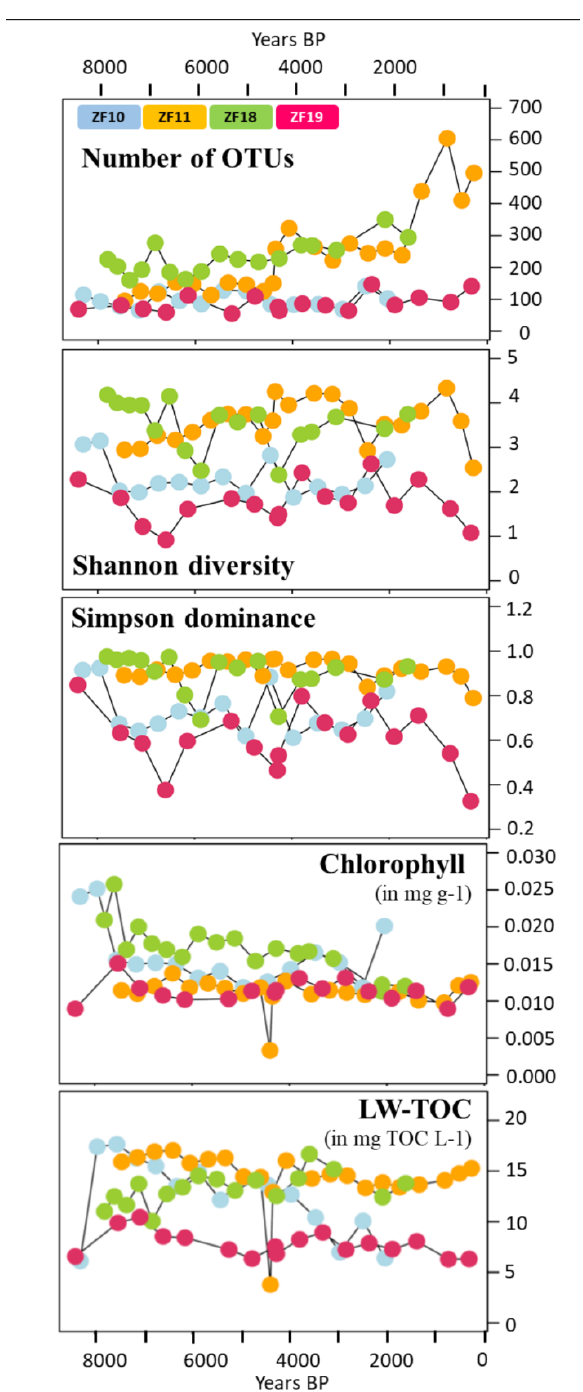
Figure 4. Time series of the diversity metrics of the microbial eukaryotic communities (OTU richness, Shannon diversity index and Simpson dominance index); sediment chlorophyll concentration (mg g − 1 ) and LW-TOC (mg TOC L − 1 ). The four colors correspond to the four lakes, as indicated in the uppermost plot. The sample corresponding to the clay layer in the ZF11 sediment profile is the one with the lowest sediment chlorophyll concentration and LW-TOC values.